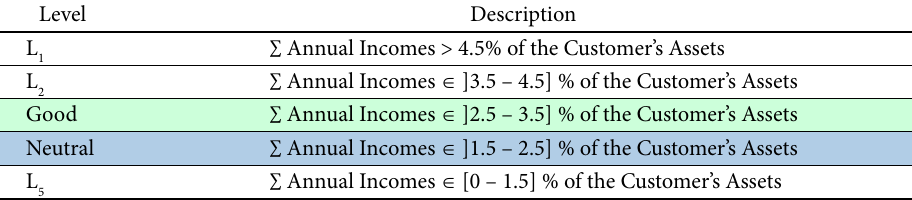
Table 1. Descriptor and impact levels for FPV